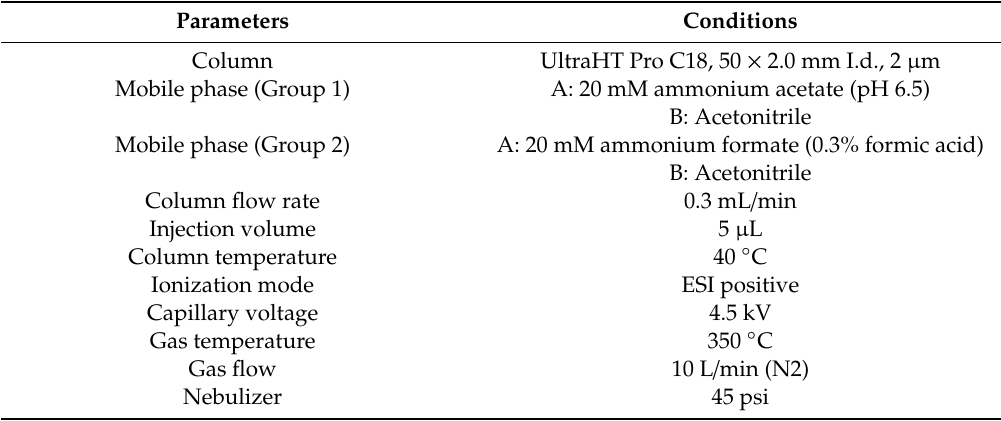
Table 4. Analytical conditions.